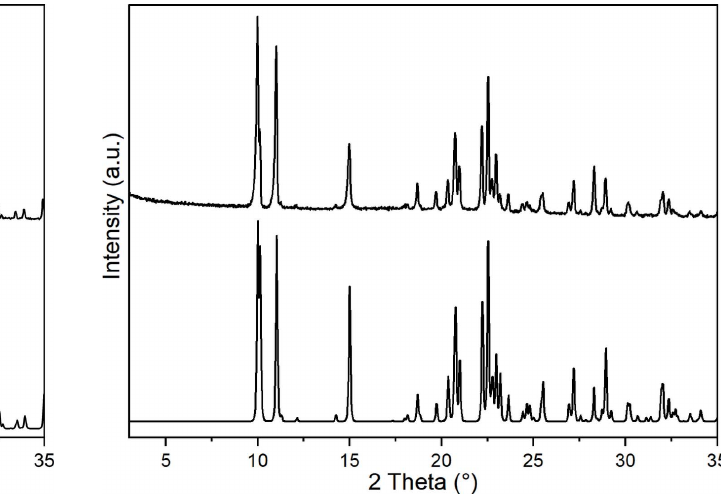
Figure 2 Experimental (top) and calculated (bottom) X-ray powder patterns of compound 2 measured with Cu K (cid:2) radiation.